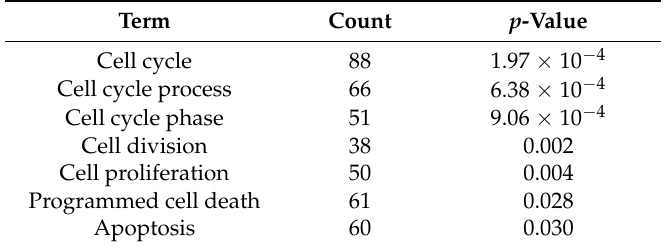
Table 3. Important gene ontology terms for miR-204 down-regulated targets.